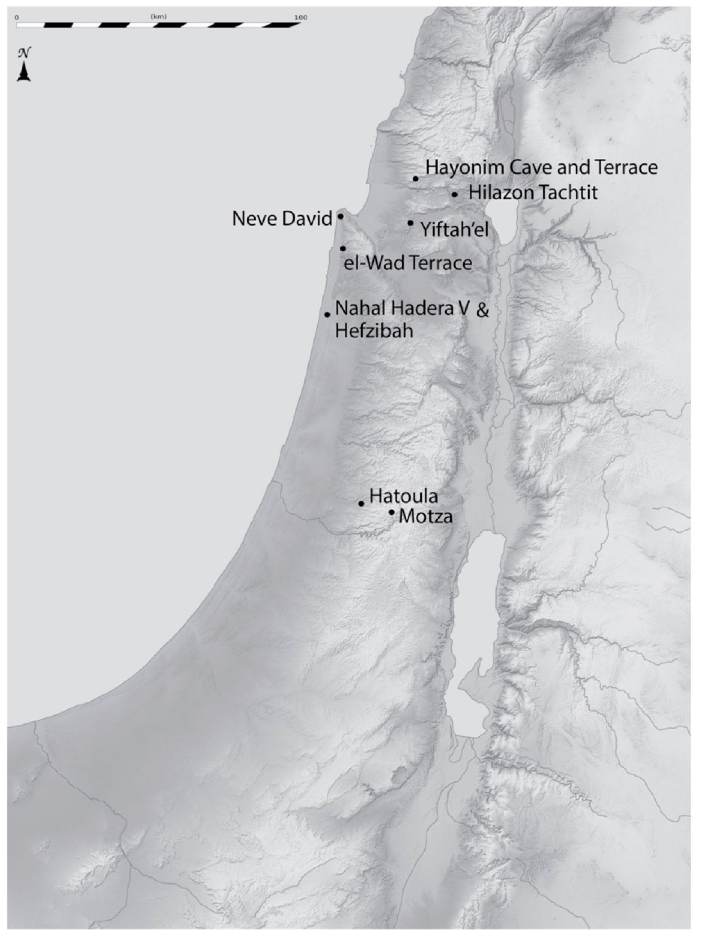
Fig 1. Map showing sites that provided faunal assemblages for this study.